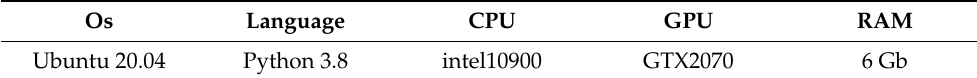
Table 2. Simulation platform